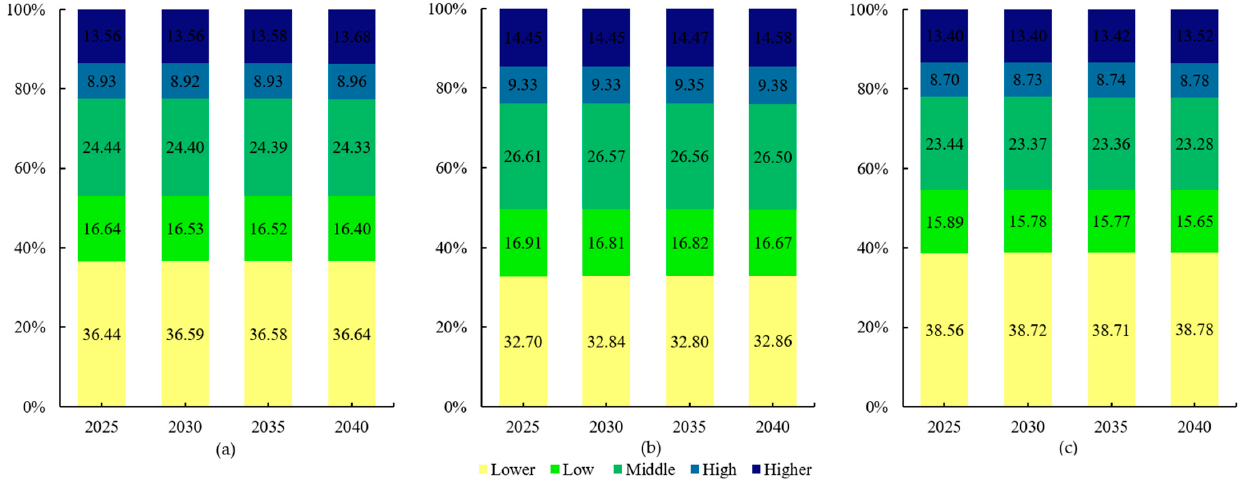
Figure 12. Proportion of habitat quality grades under different scenarios in 2025, 2030, 2035, and 2040: ( a ) natural development scenario; ( b ) ecological protection scenario; and ( c ) urban expansion